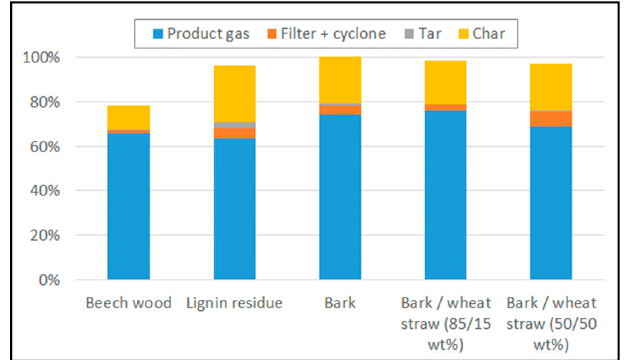
Figure 3. Carbon balance for each experiment.